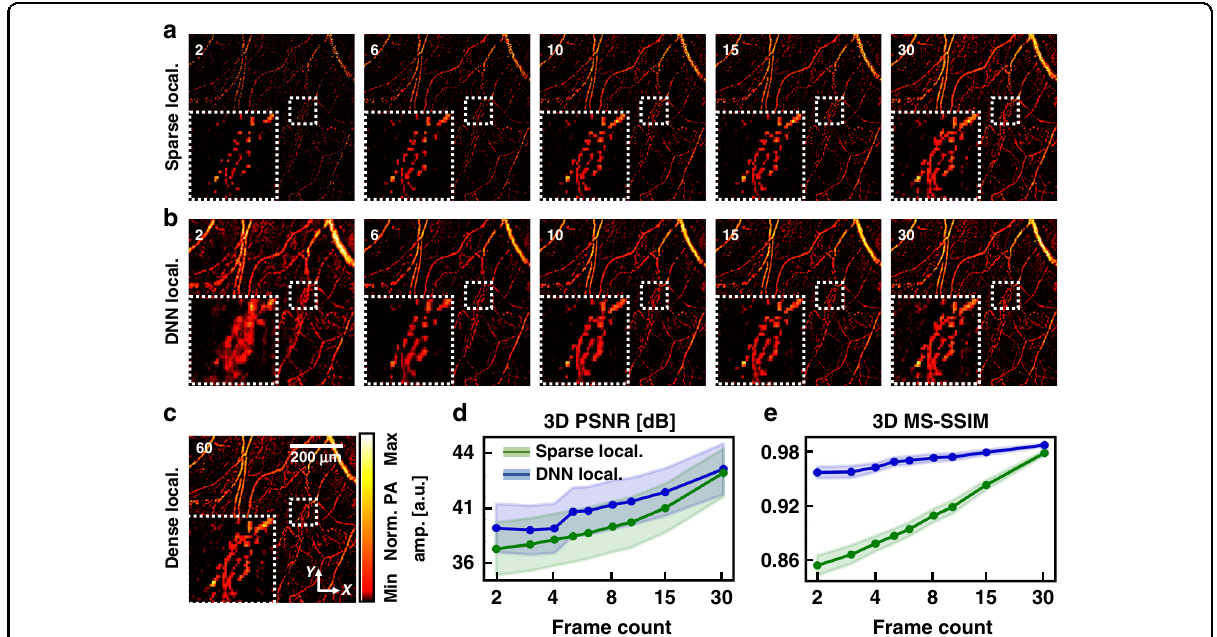
Fig. 3 Performance of 3D deep-learning localization OR-PAM depending on frame counts. a Sparse localization OR-PAM images reconstructed with 2, 6, 10, 15, and 30 frames. b DNN localization OR-PAM images generated from sparse images. c A dense localization OR-PAM image reconstructed with 60 frames. All images correspond to images in Fig. 2. Graphs for d 3D PSNR and e 3D MS-SSIM evaluation metrics for frame counts of 2, 3, 4, 5, 6, 8, 10, 15, and 30. OR-PAM optical-resolution photoacoustic microscopy, PA photoacoustic, Sparse local. sparse localization-based PA image, DNN local. deep neural network localization-based PA image, Dense local. dense localization-based PA image, Rep. repetition count, Norm. PA amp. normalized PA amplitude, PSNR peak signal-to-noise ratio, MS-SSIM multiscale structural